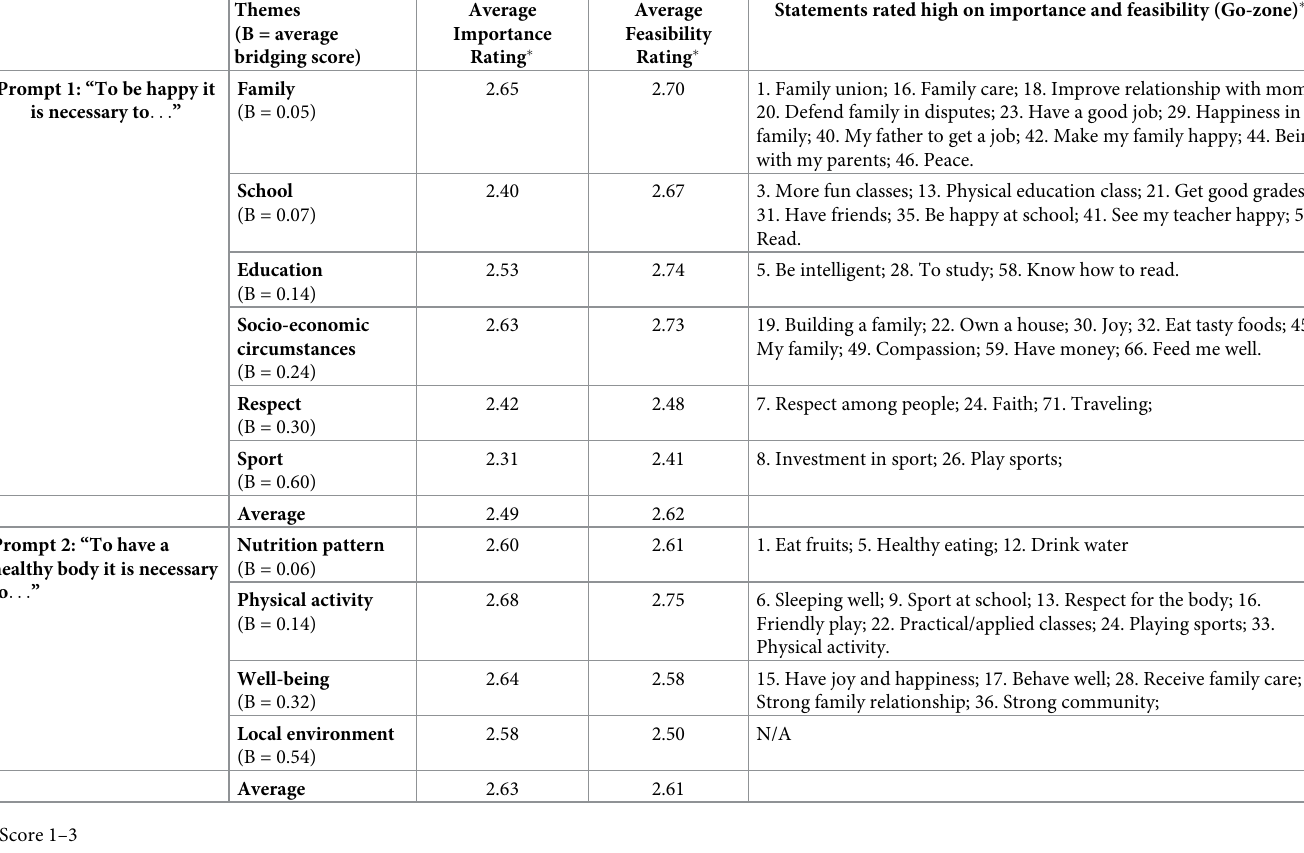
Table 1. Synthesis of highly rated statements in the Go Zone, based on their response to the two